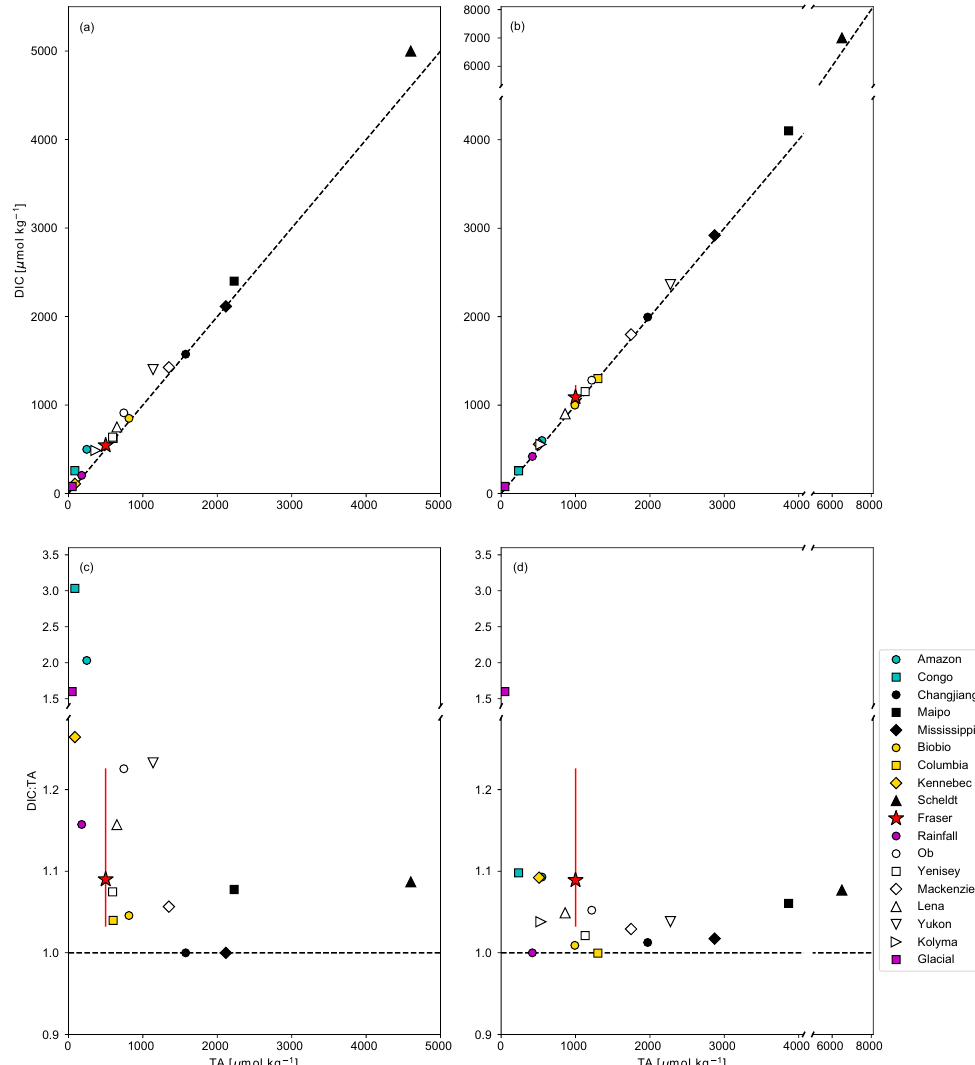
Figure 8. DIC and TA literature values for selected world rivers (Table S2) at the (a, c) low and (b, d) high ends of the reported ranges. The dashed lines are the DIC:TA 1 : 1 lines. The legend is in order of increasing latitude. Cyan symbols represent tropical watersheds, black symbols represent urbanized/polluted watersheds, yellow symbols represent temperate watersheds, magenta symbols represent watershed type proxies, and white symbols represent Arctic watersheds. The Fraser River DIC and TA endmembers used in this study (Table 2) are shown as a red star with error bars to represent the range of DIC f :TA f scenarios. DIC data are unavailable for the Columbia River and thus calculated using reported TA and p CO 2 ranges. DIC and p CO 2 data are unavailable for the Arctic rivers and DIC is thus calculated from reported TA and pH ranges. TA data are unavailable for the Maipo and Biobio rivers and thus calculated using DIC and p CO 2 . For most rivers, DIC:TA can be significantly greater than 1 (c, d) despite falling visually close to the 1 : 1 line (a, b) . Uncertainty is not shown and not always